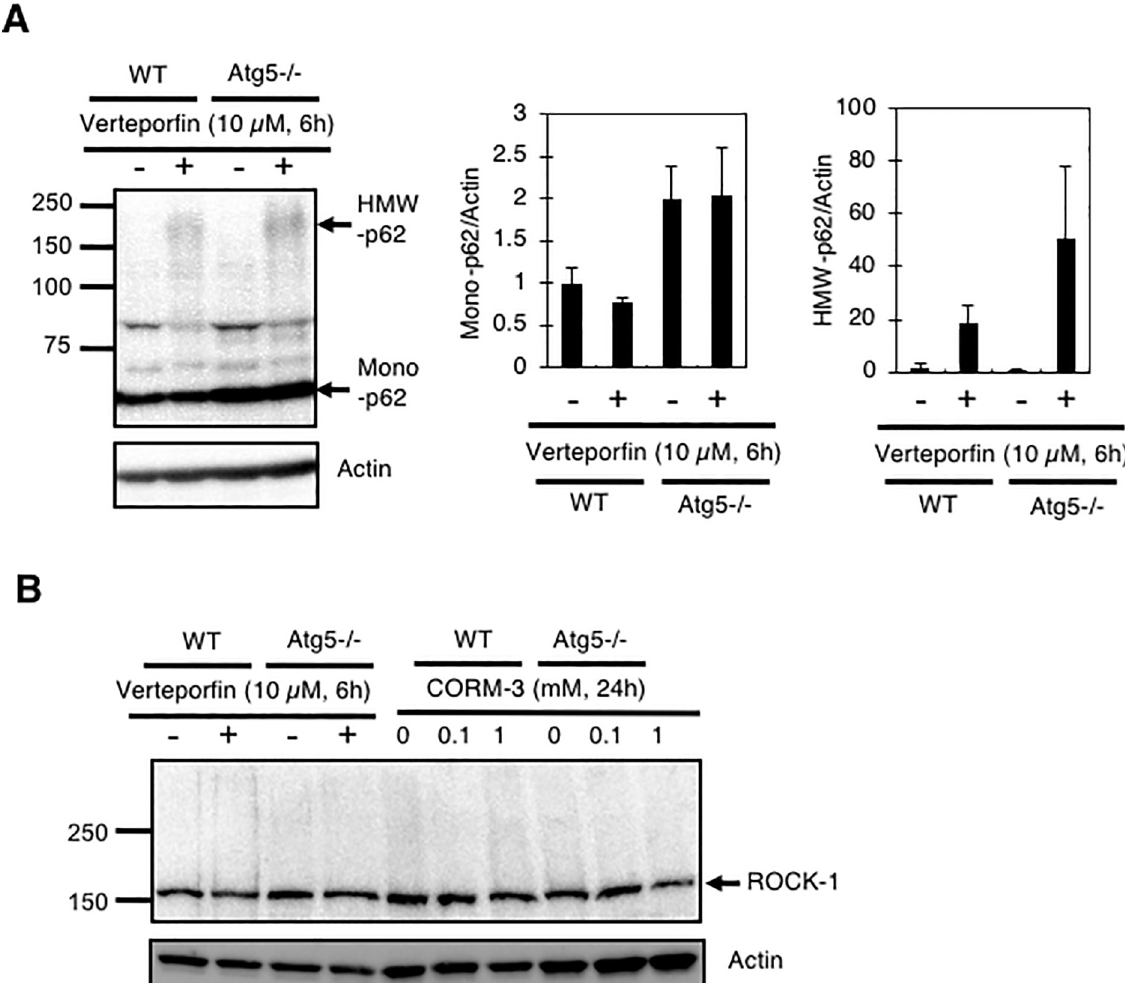
Fig 3. Generation of HMW-p62 by verteporfin in MEFs. (A) MEFs treated with 10 μ M verteporfin for 6 hours were subjected to immunoblot analysis using anti-p62 antibody. Relative levels of p62 to actin are shown as means and S.E. (n = 4). (B) Lack of HMW-ROCK-1 in WT and atg5-/-MEFs treated with verteporfin or CORM-3. MEFs treated with 10 μ M verteporfin for 6 hours or 1 mM CORM-3 for 24 hours were subjected to immunoblot analysis using anti-ROCK-1 antibody.